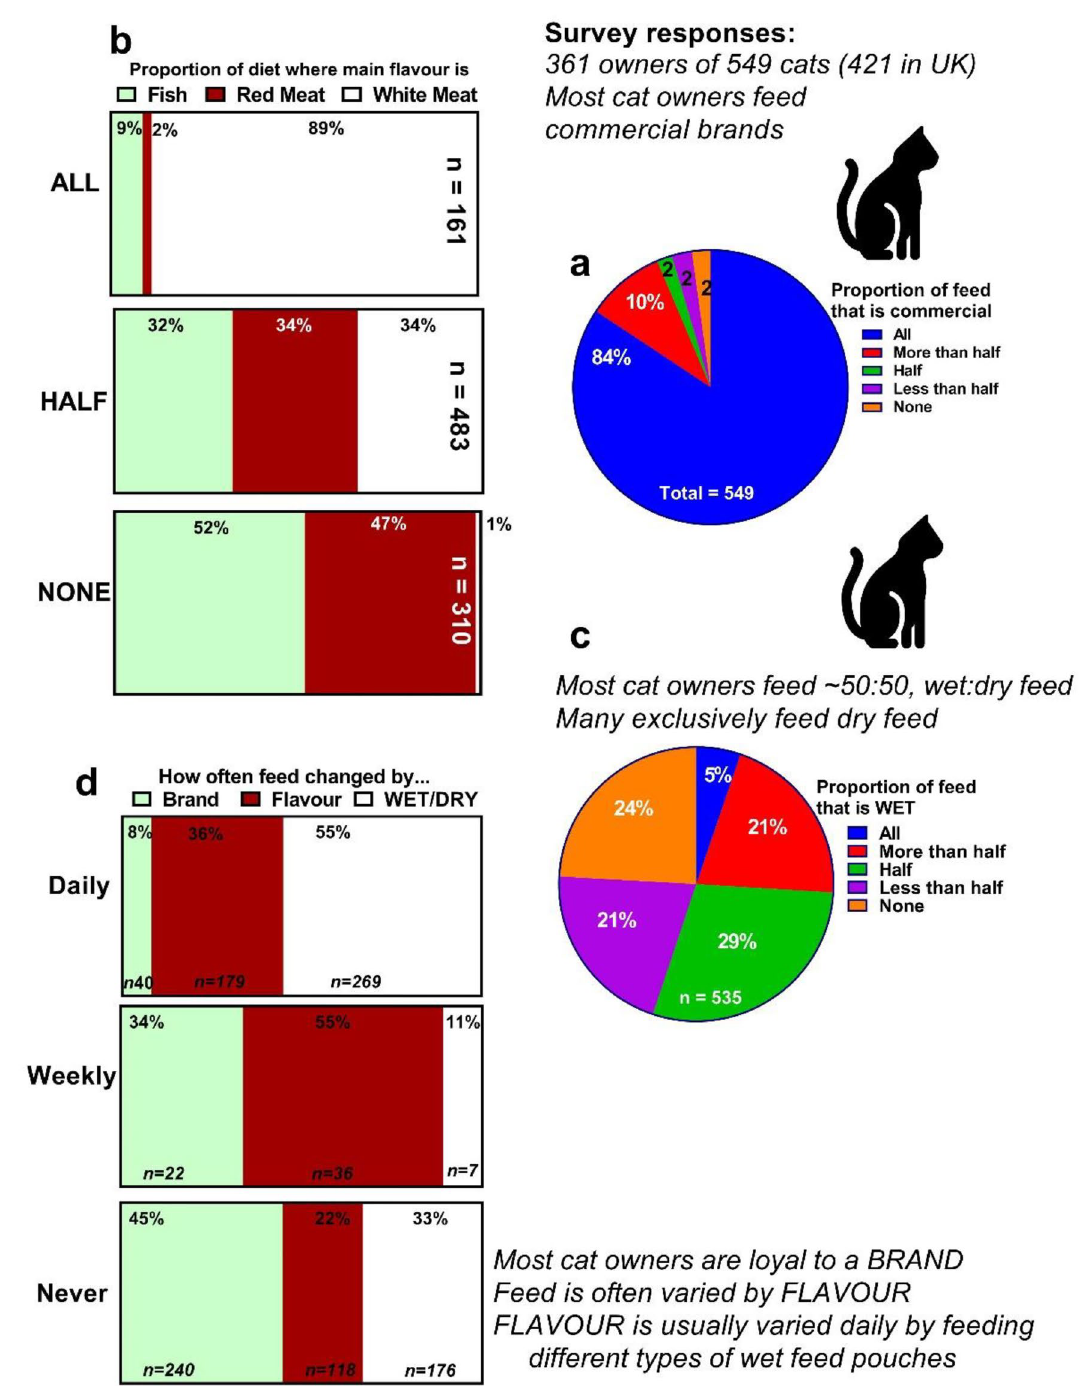
Figure 1. An international survey of cat owners regarding their feeding habits. Survey responses from n = 361 cat owners of n = 549 cats about their cats’ feeding habits. ( a) Proportion of feed that is ‘commercially-available’ cat food, rather than home-made. ( b) Proportion of feed according to main flavour given to cats; ( c) proportion of the cat’s commercial diet fed as wet, as opposed to dry, feed; ( d) proportion of owners changing the brand, flavour or type (e.g. wet to dry) of feed given to their cats. The survey of cat feeding habits was created using Jisc Online Surveys. The numbers indicate the number of cats, rather than number of owners, for which the particular response option was selected. Any variation from expected proportions were analysed using Pearson chi-square, as indicated in text of results. Cartoon image of a cat obtained from Microsoft, CC-BY-4.0